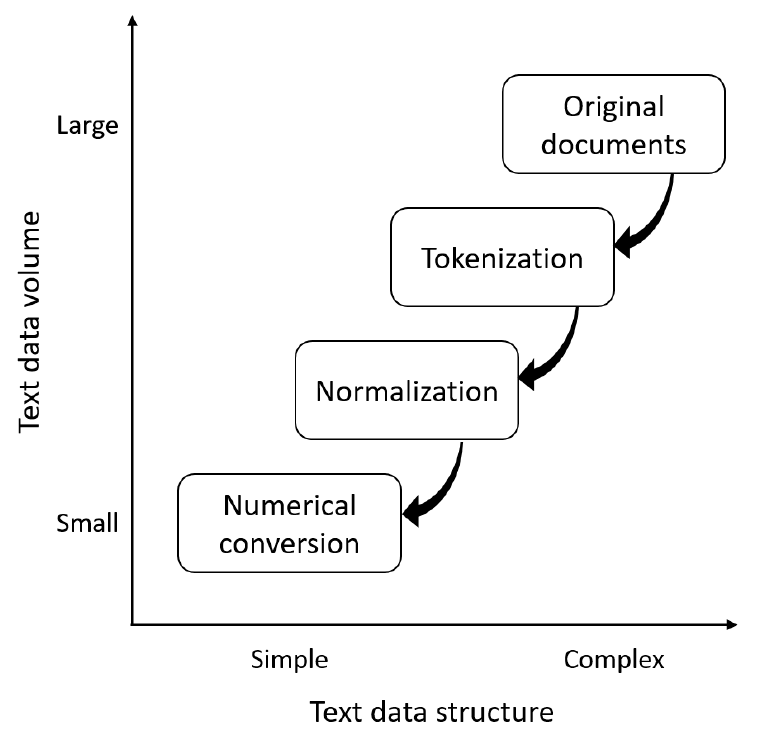
Figure 3. Framework for preprocessing dock specification texture data from the collected documents.